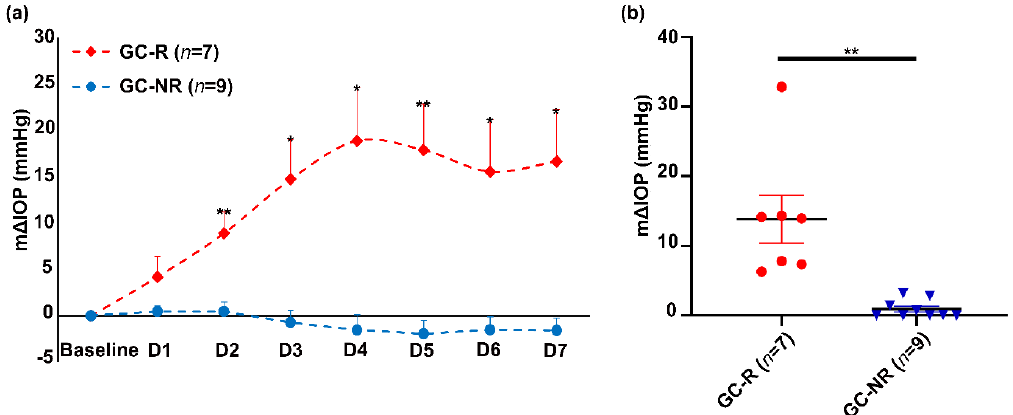
Figure 1. Effect of DEX on IOP ( a ) The mean ± SEM of ∆ IOP of DEX-treated responder and non- responder eyes were plotted over time. The basal IOP on day 0 (before DEX treatment) was set at 0 mmHg. Treatment with DEX showed a significant elevated IOP in 7/16 eyes (Mean ± SEM-m ∆ IOP: 13.8 ± 3.41 mmHg; response rate: 43.8%). ( b ) Frequency plot of IOP data. The m ∆ IOP of GC-R and GC-NR groups were plotted. The m ∆ IOP was increased after DEX treatment in GC-R eyes as compared to GC-NR eyes. Data were analyzed by unpaired 2-tailed Student’s t-test on each treatment day; * p < 0.05; ** p < 0.001.